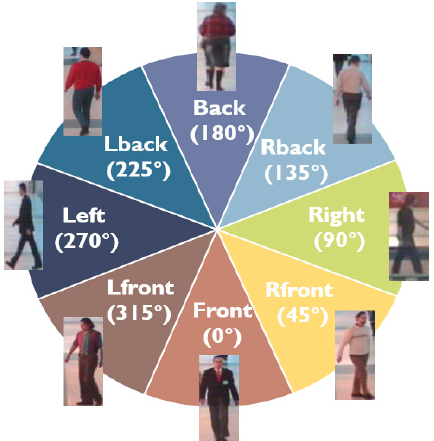
Figure 2. Eight orientations recognized by the proposed system and corresponding examples of pedestrian poses.